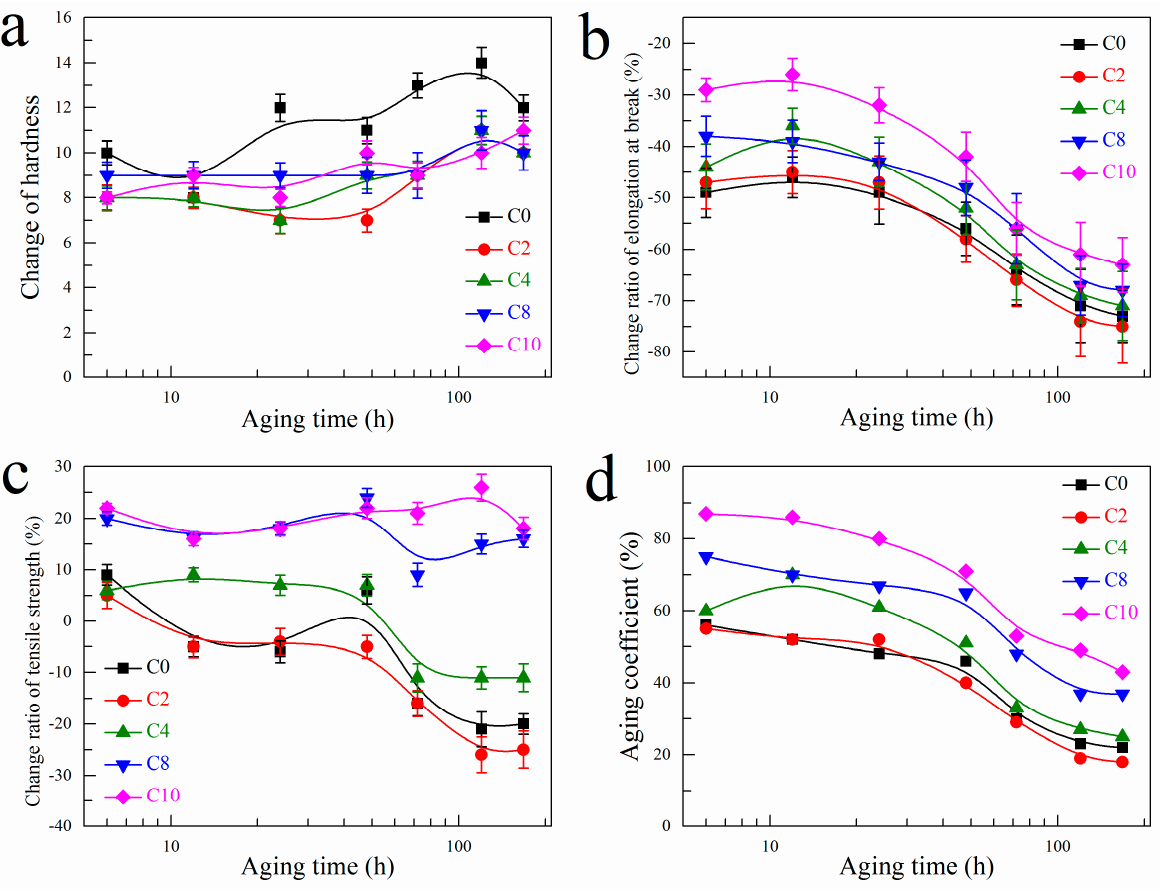
Figure 3. ( a ) Change of Shore A hardness, ( b ) change ratio of elongation at break, ( c ) change ratio of tensile strength and ( d ) aging coefficient for EPDM composites at various aging time.